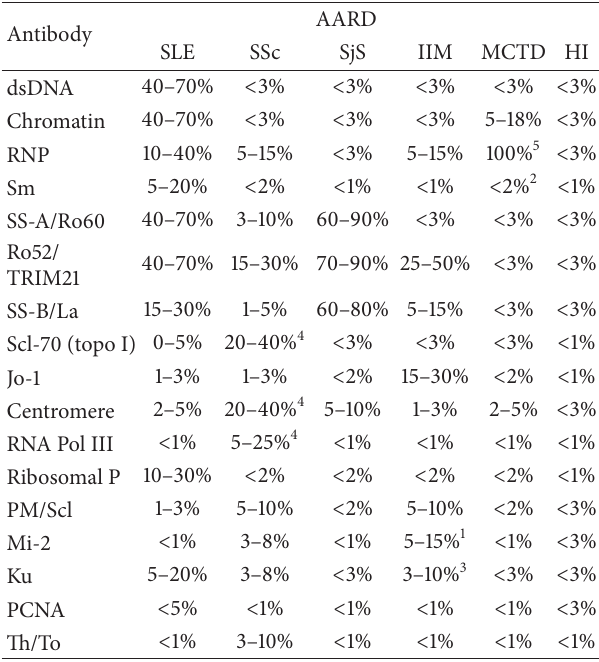
Table 2: Anti-nuclear antibodies (ANA) in different ANA associ- ated autoimmune rheumatic diseases and healthy